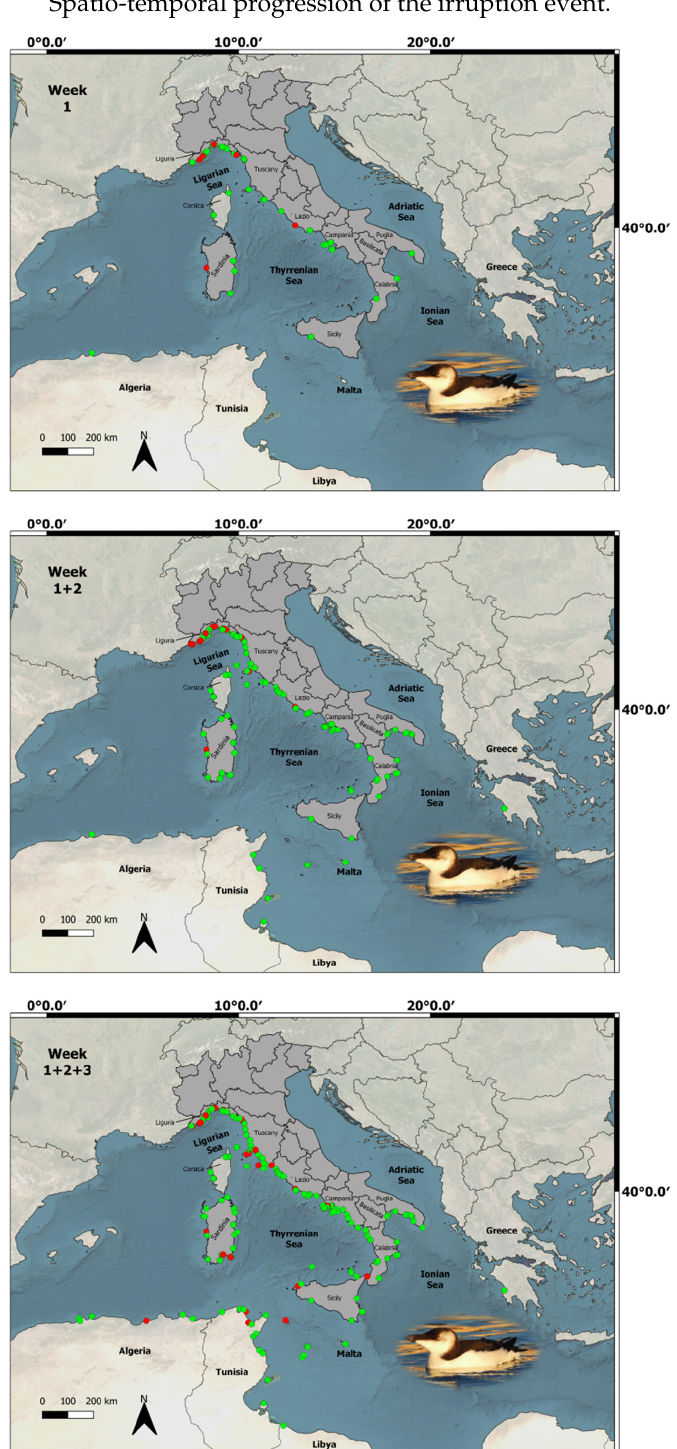
Figure A1. Spatio-temporal progression of the irruption event, based on observation records of Razorbill, for the 3-week period during November–December 2022 in the central Mediterranean area. The observation records are cumulatively plotted on the maps by week (Week 1; Week 1 + 2; Week 1 + 2 + 3). The dots represent the community participation in the collection of all records (including possible multiple counts), where alive (green) or dead (red) individuals are indicated. The names of countries, regions and seas are shown on the